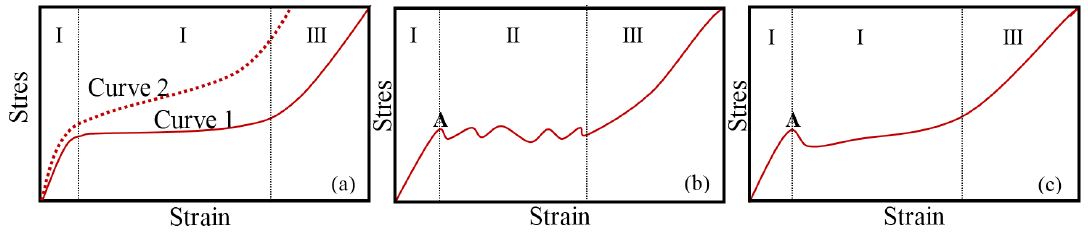
Figure 3. Schematic representation of typical stress ‐ strain curves ( a – c ) measured for metal foam under uniaxial compression characterized by quasi ‐ static (I); plateau (II); and densification (III) regions.